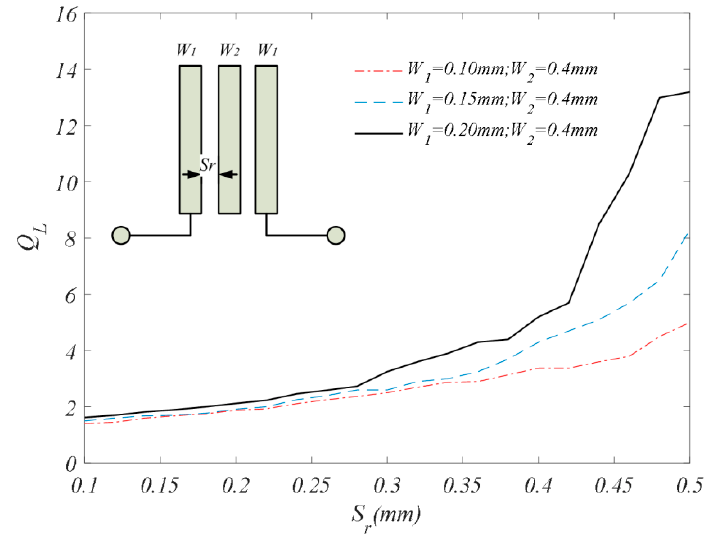
Figure 8. Effect of three-line width on quality factor.